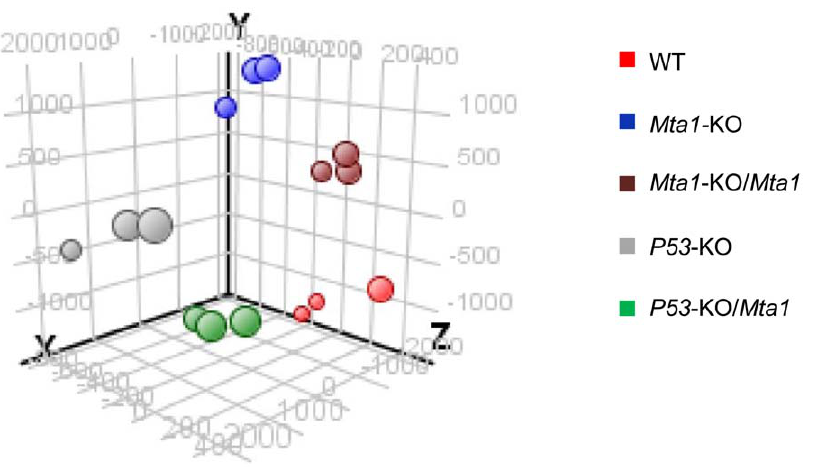
Figure 2. Principle Component Analysis as a quality control. All the sample sets (each in triplicates) were plotted in the 3-D PCA-plot. Out of the 4 total PCA components, components 1, 2 & 4 were plotted on columns X, Y & Z respectively.